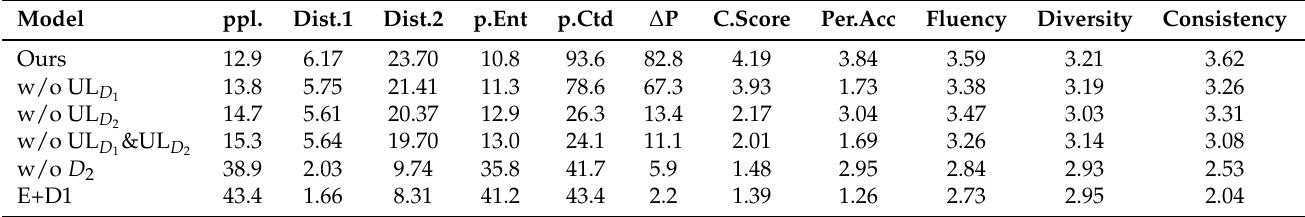
Table 6. Ablation study results of PersonalDialog